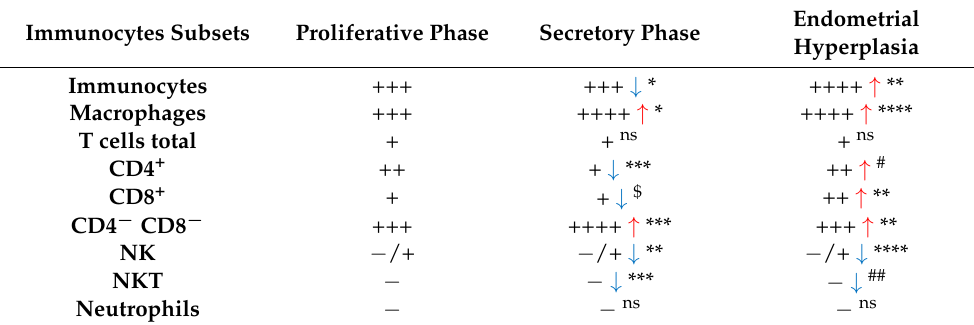
Table 4. The proportion changes in immunocyte subtypes in different